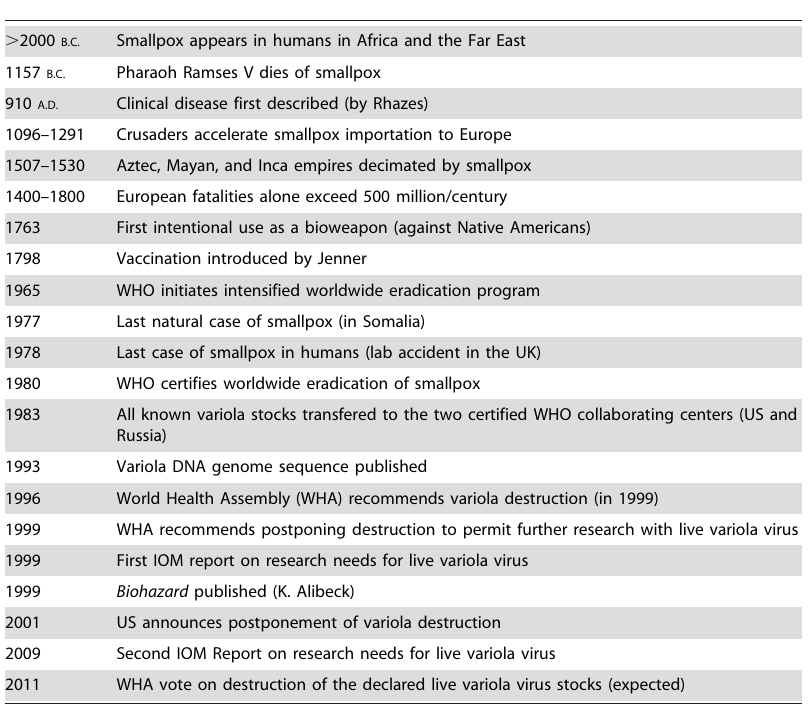
Table 1. History of Smallpox: Timeline of a Serial